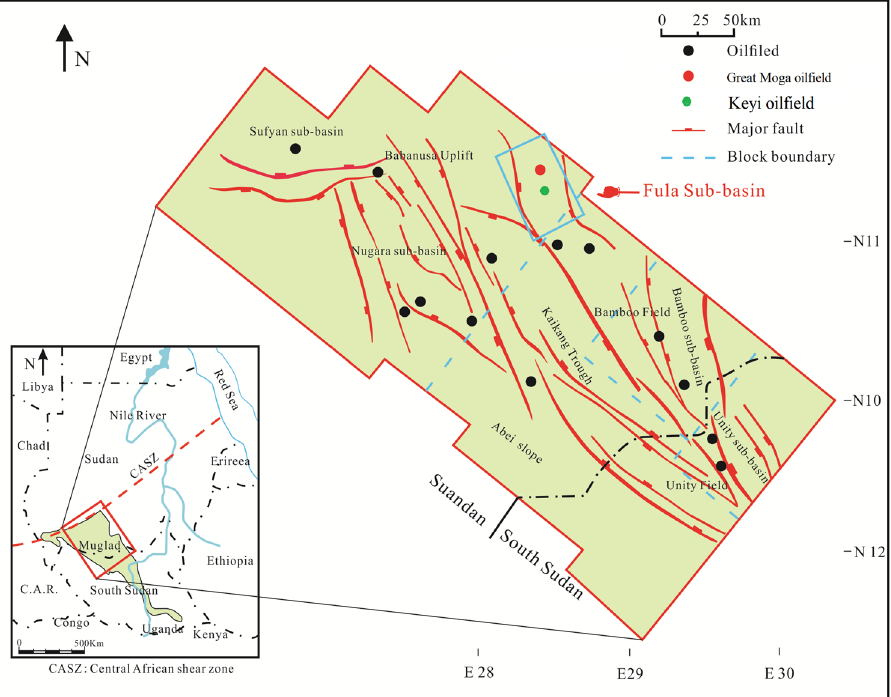
Figure 1. Location map showing the Great Moga and Keyi oilfields as well as the main oilfields discovered, major fault and block boundary, Fula Sub-Basin, Muglad Basin, Sudan (created from information in reference 1,2